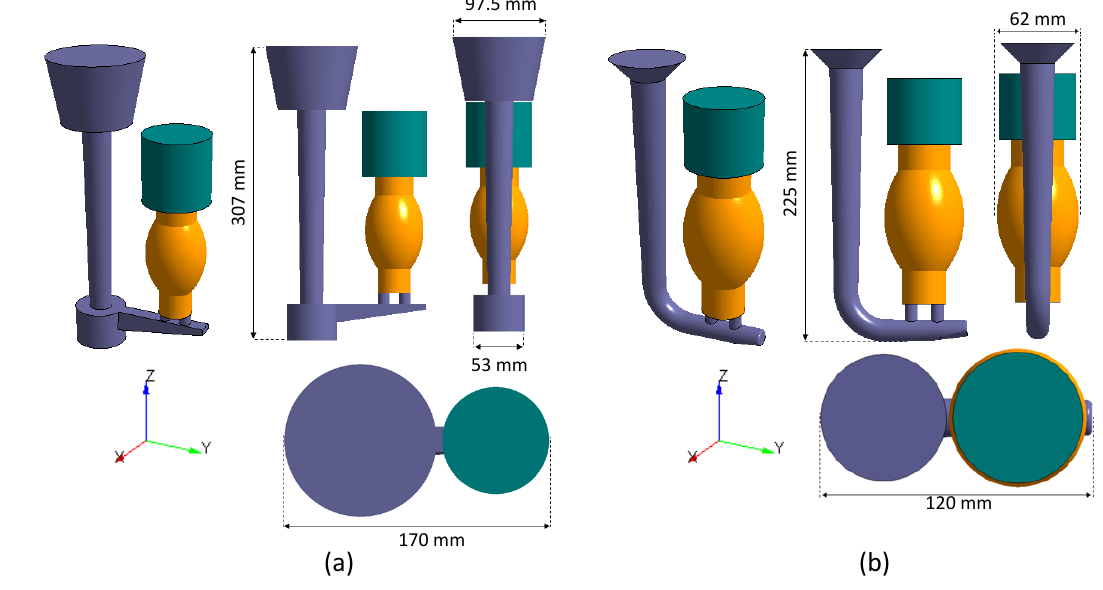
Table 2. Thermophysical parameters of the cast material.